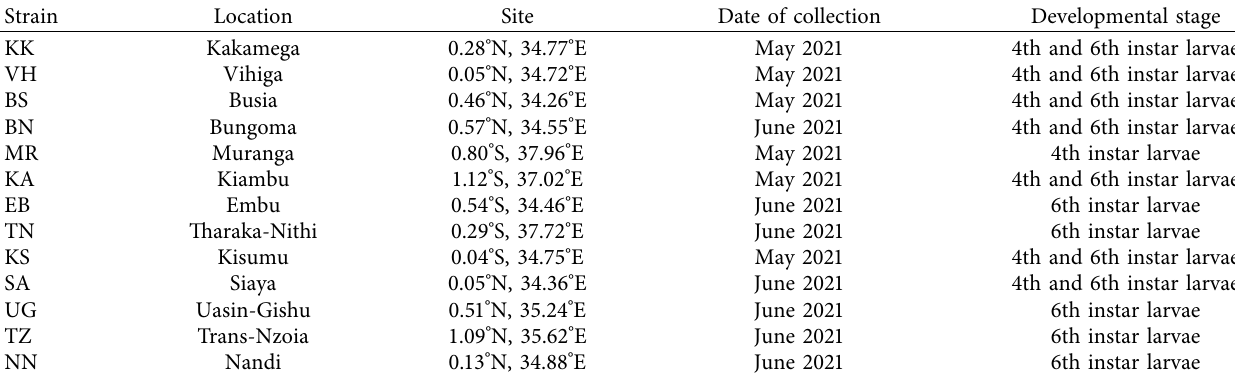
Table 1: Sampling site, date of sampling, and developmental stage of Spodoptera frugiperda .